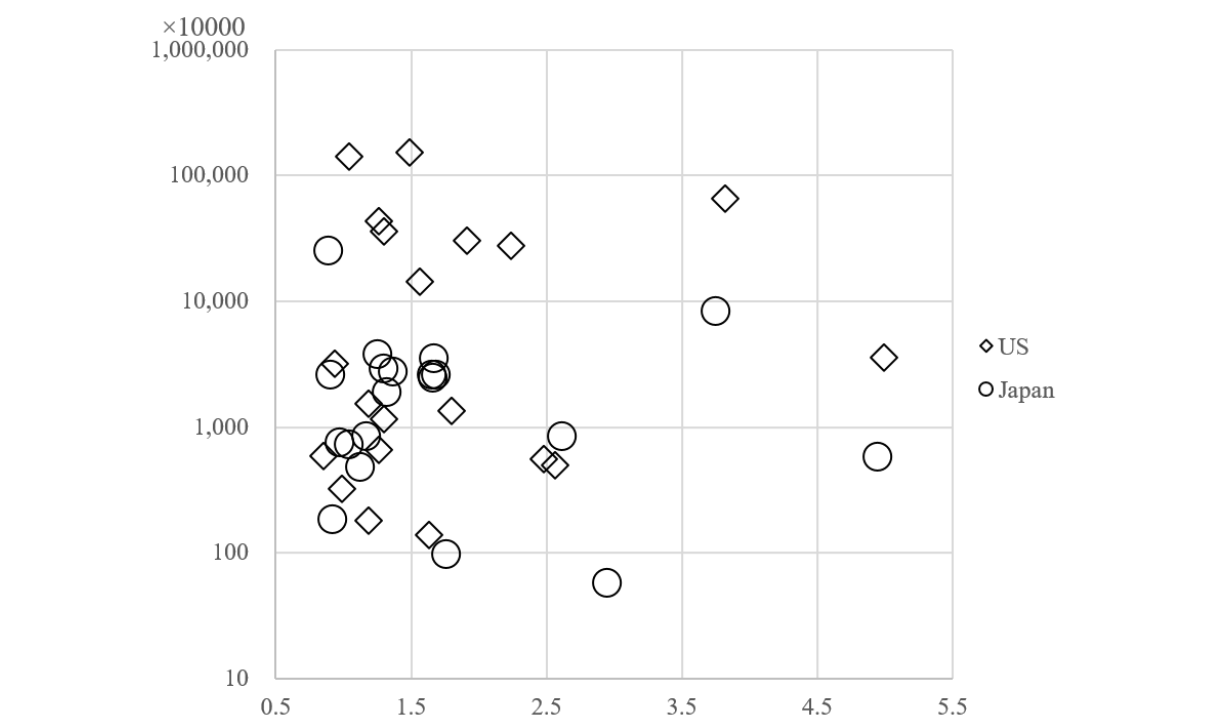
Figure 3. Search volumes and number of total hit websites. Vertical axis: Number of total hit websites (logarithmic scale). Horizontal axis: Four-year search volume per 100 people. No significant difference was observed in the relationship between the search volume and the number of total hit websites (Spearman rank correlation